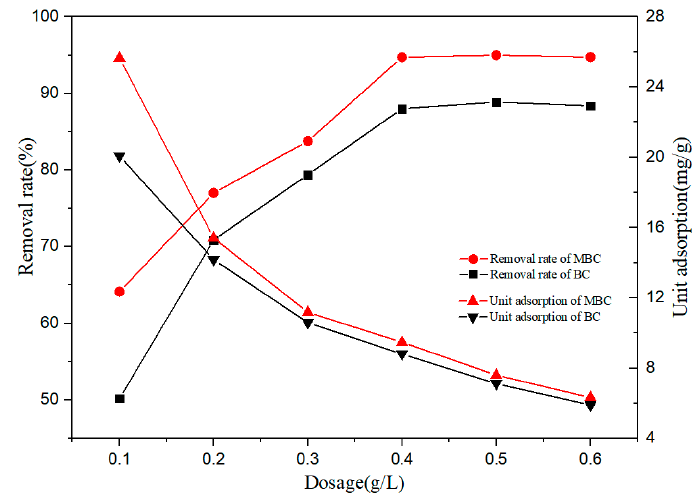
Figure 3. Effects of BC and MBC dosage on BPA adsorption. Figure 3. E ff ects of BC and MBC dosage on BPA adsorption.